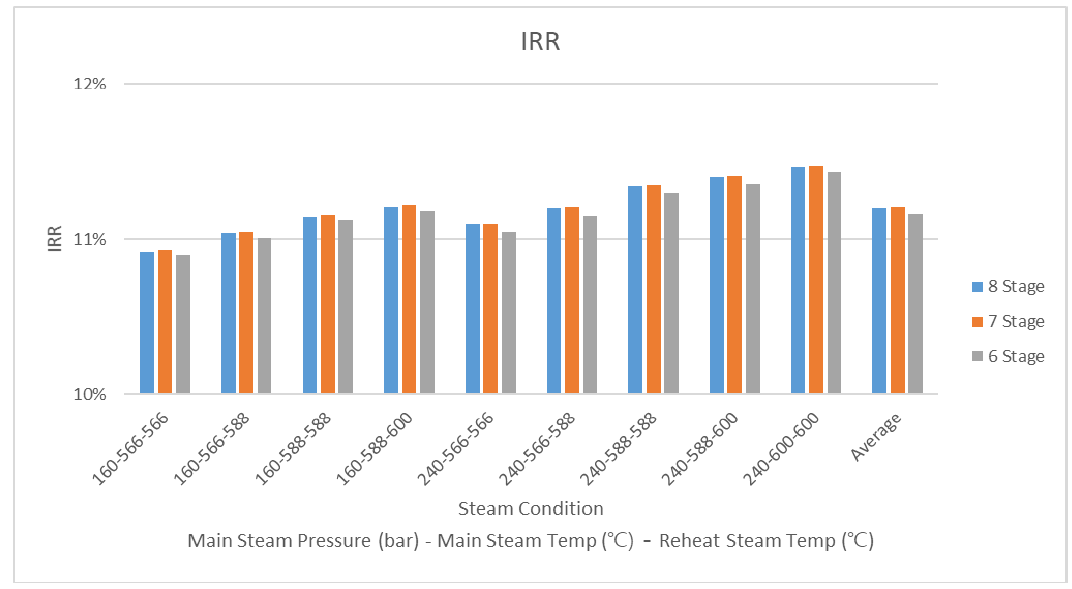
Figure 6. CAPEX average according to steam condition and heater stage.